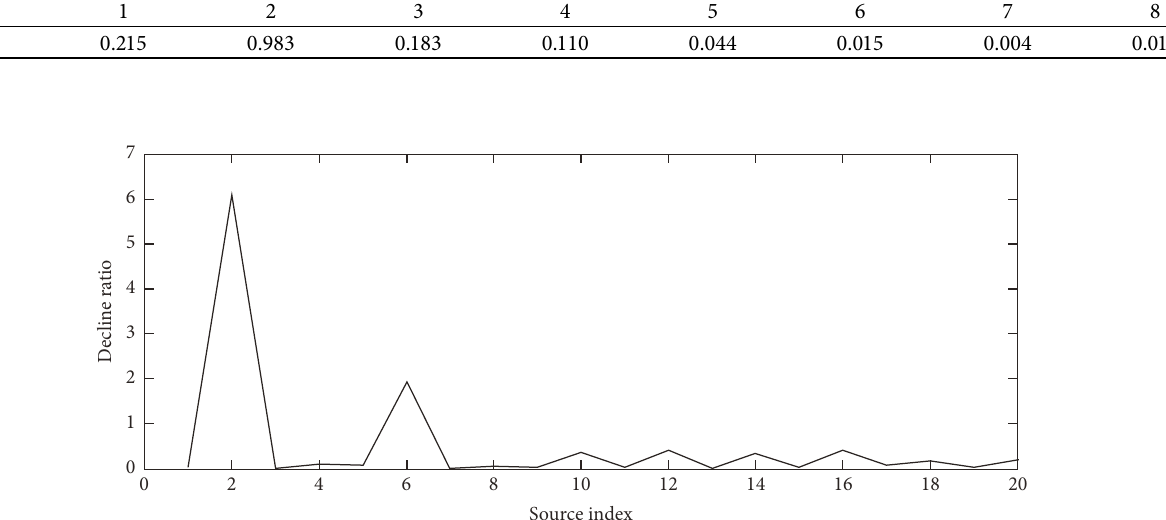
Figure 6: Changes of decline ratio with source